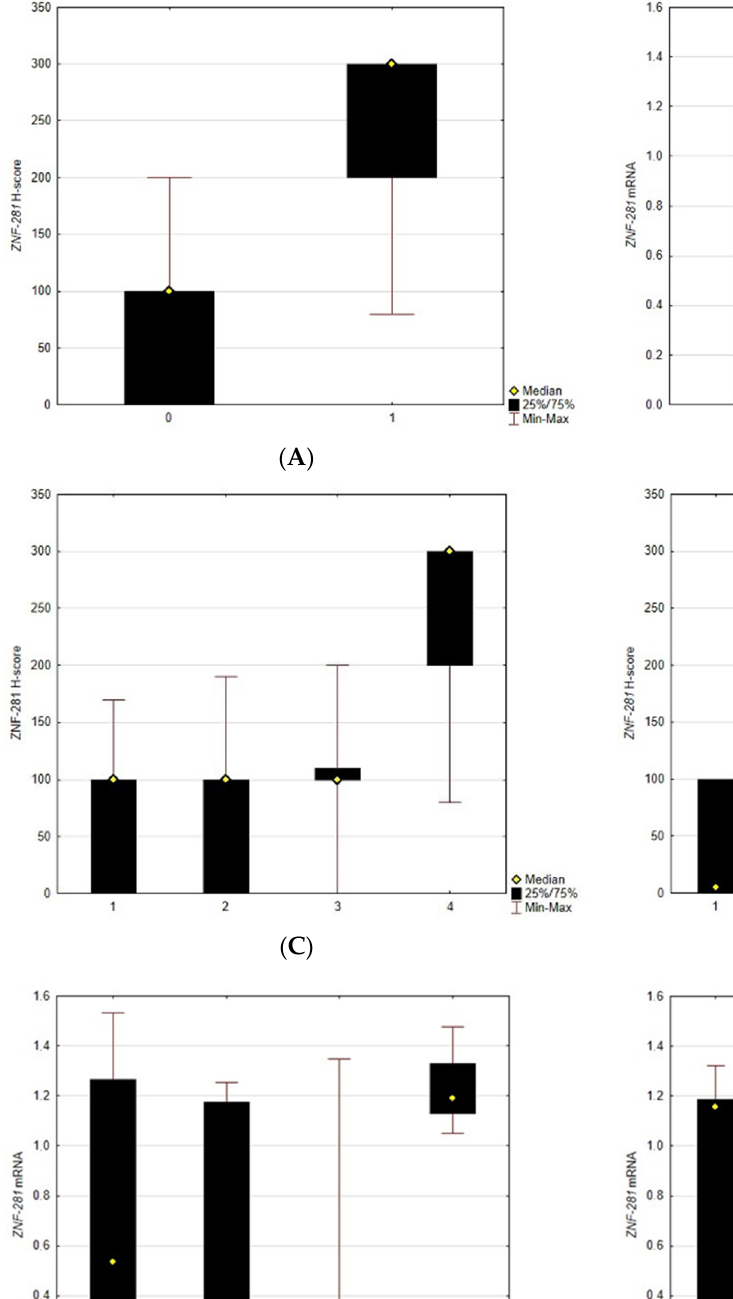
( B ) Figure 3. ROC curves for differentiation of OSCC from normal tissue and their accuracy using ( A ) H-score and ( B ) ZNF- 281 mRNA transcript level normalized with ACTB gene. 2.3. Impact of ZNF-281 on Survival The number of deaths in this group was 47 (71.2%). The median overall survival (OS) was 37.5 (2–135) months, and 5-year disease-free survival was 43.9%. In order to deter- mine the impact of the ZNF-281 H-score and mRNA relative expression level on overall